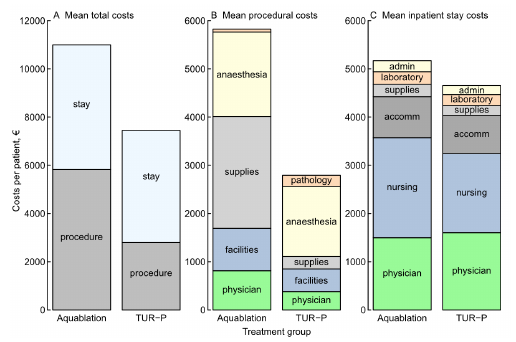
Figure 2: Cost summary for aquablation and TURP grouped by mean total (A), procedural (B), and inpatient stay (C). stay: